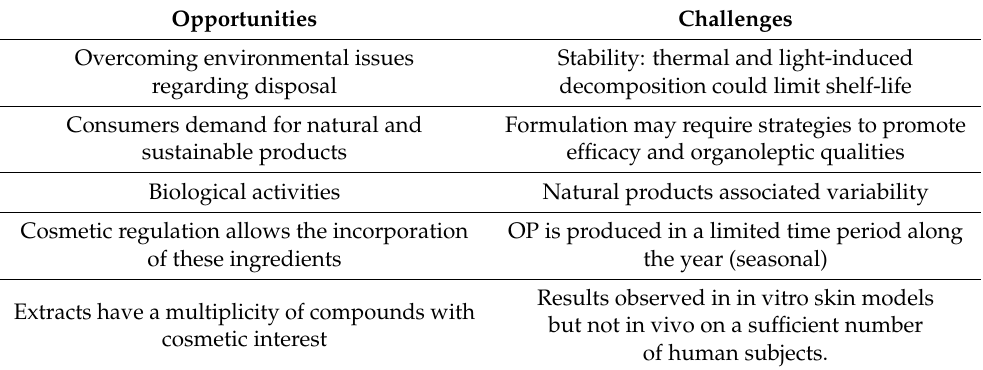
Table 4. Opportunities and challenges in the use of olive